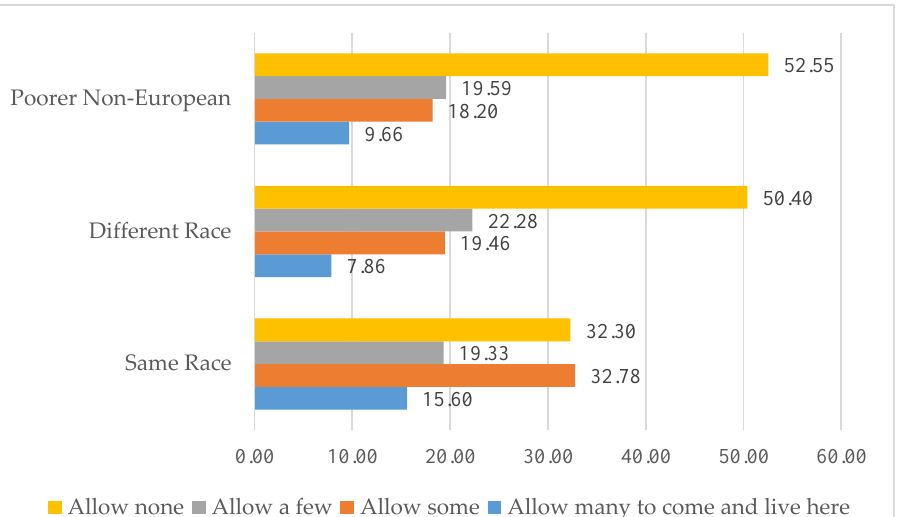
Figure 1. Distribution of survey answers for questions about allowing more immigrants, weighted. Source: Author’s calculation based on ESS (Round2) .